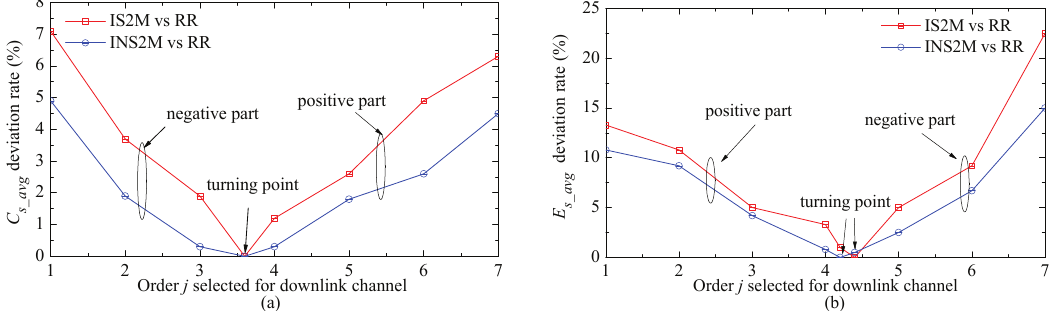
Figure 3. The average system capacity and the total collected energy obtained by IS2M, INS2M and RR scheduling mechanism in the Nakagami- m fading channel with N = 7 and m = 3. ( a ) average system capacity; ( b ) average collected